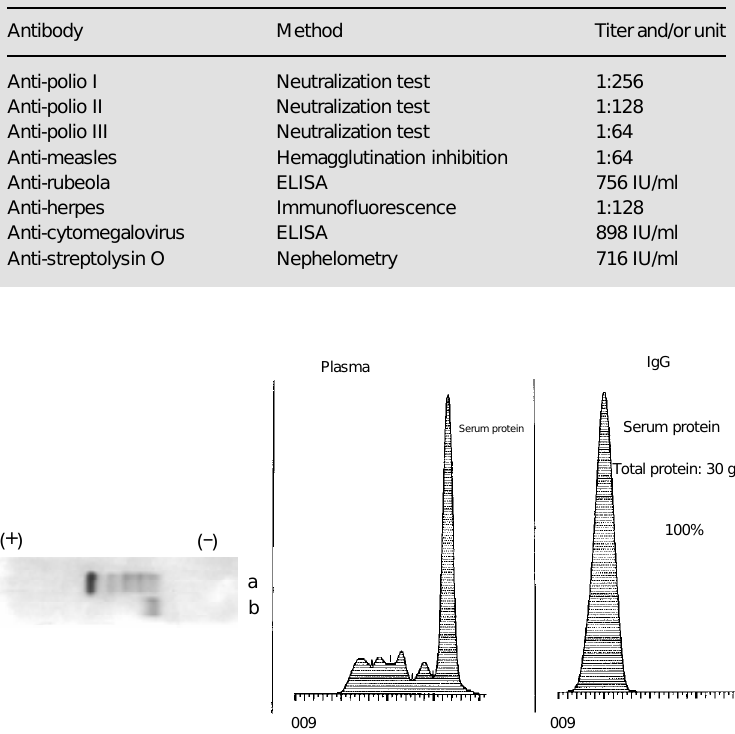
Table 3 - Antibodies detected in liquid intravenous IgG. N = 10.